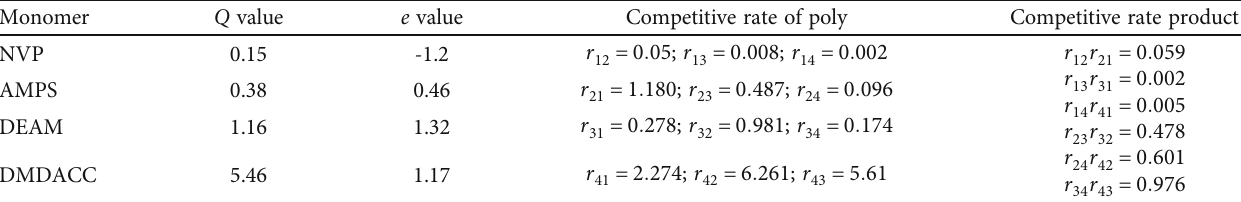
Table 1: Estimation results of monomer ’ s reactivity ratio.